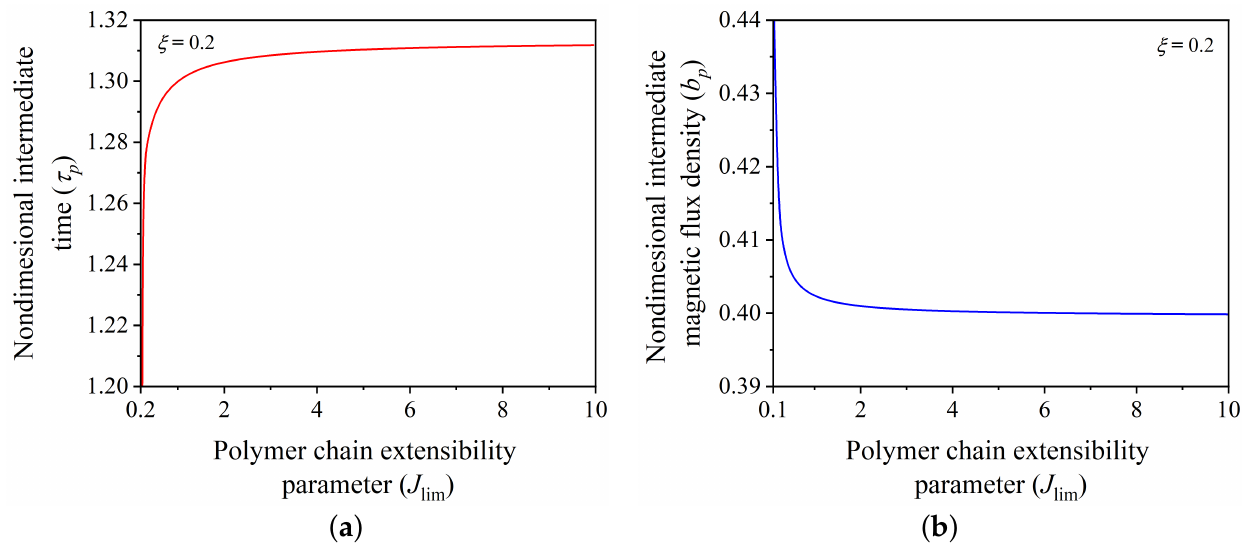
Figure 10. Variation of ( a ) nondimensional intermediate time ( τ p ) and ( b ) nondimensional interme- diate magnetic flux density ( b p ) required by the hard-magnetic soft actuator to attain the desired equilibrium position as a function of extensibility of polymer chains ( J lim )